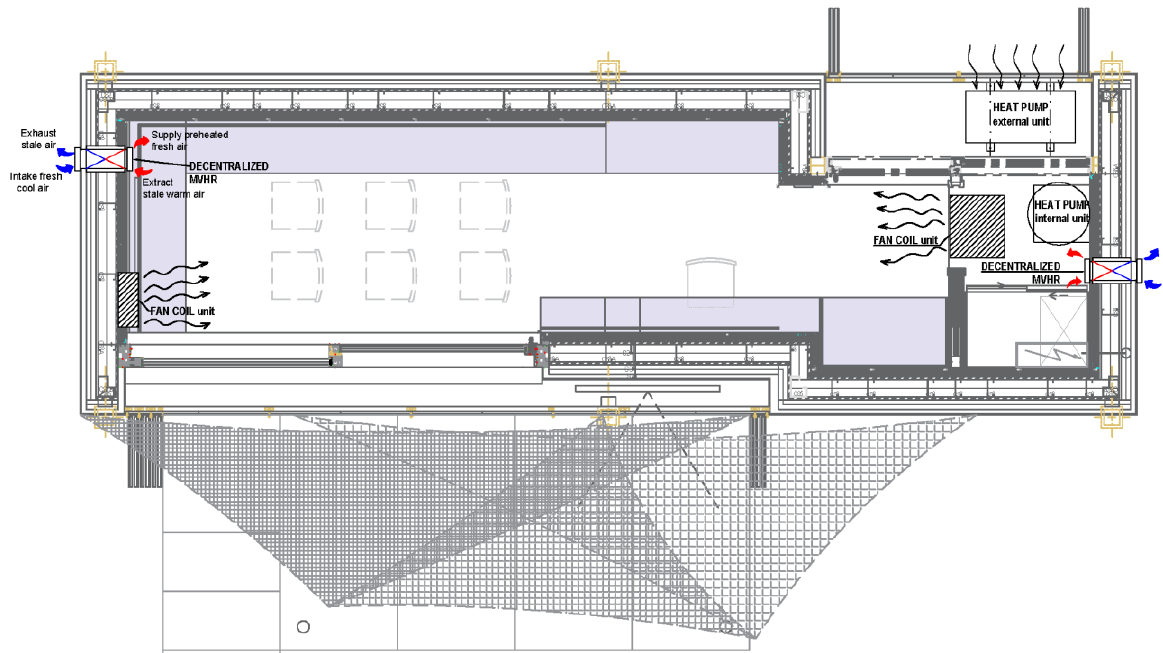
Figure 7. Floor plan with position of technical systems.